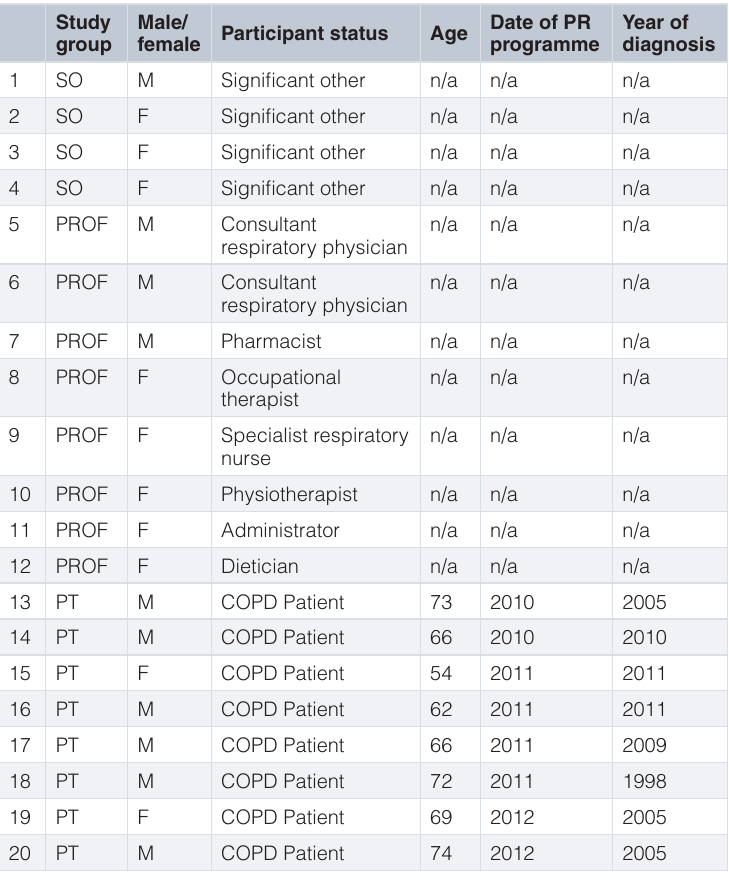
Table 1. Summary of three Chronic Obstructive Pulmonary Disease (COPD) workshop participant